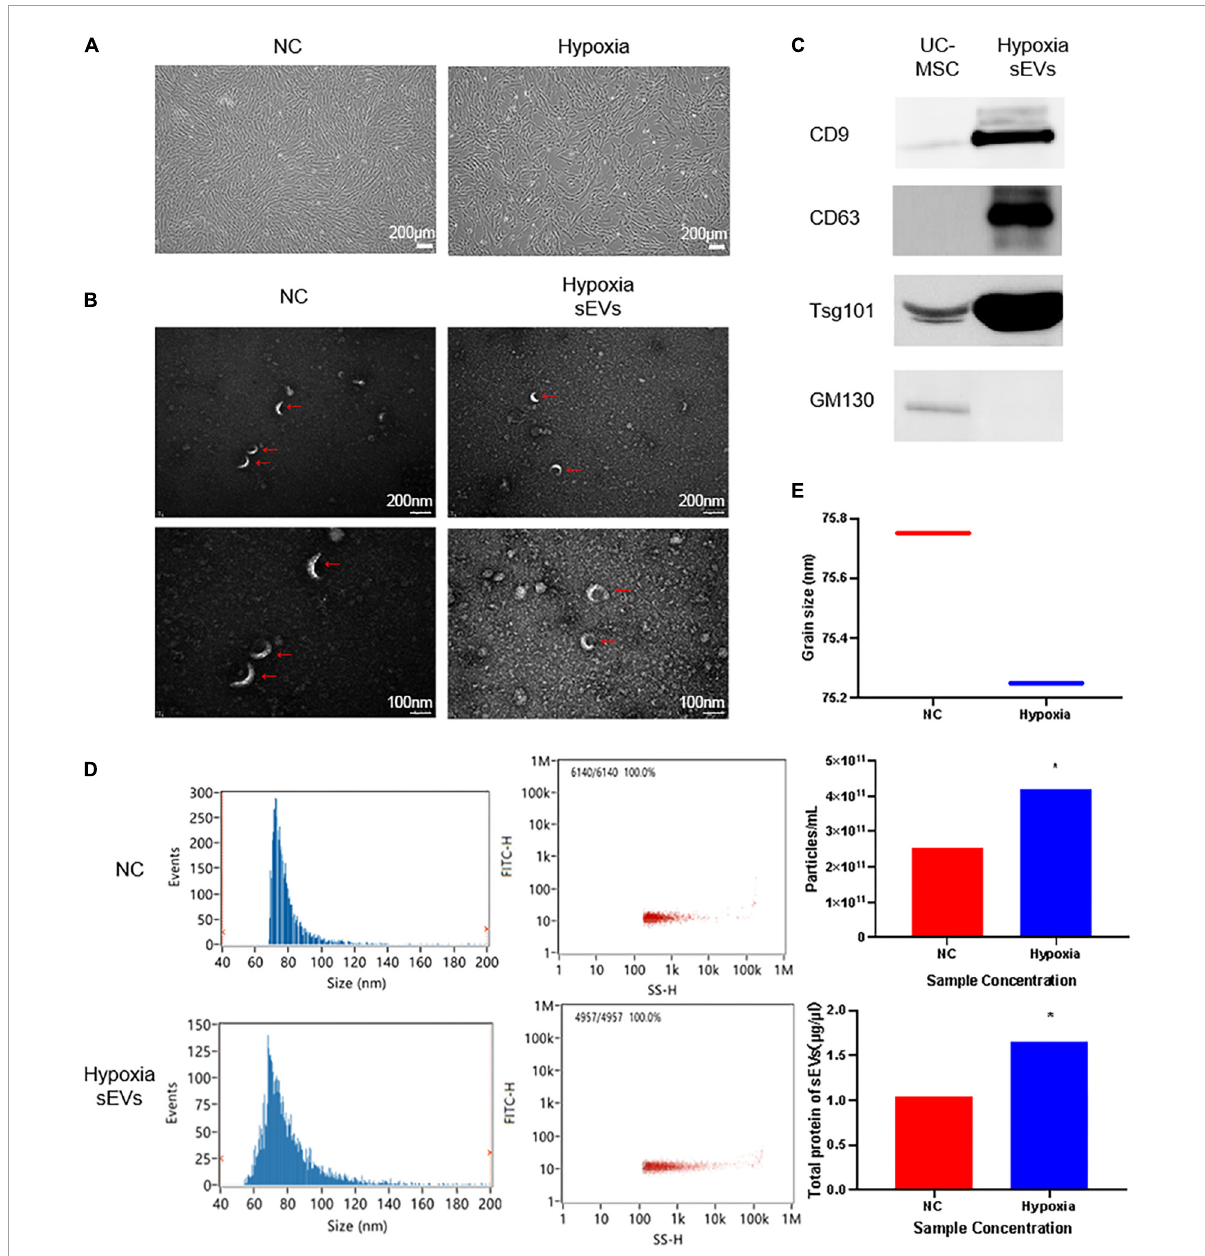
FIGURE1 Identification of UC-MSC-derived sEVs in hypoxic culture: (A) Cell culture: UC-MSCs under normoxic culture and hypoxic culture underwent microscopic examination to assess their morphology. UC-MSCs were seeded in T175 flasks at a density of 0.6 × 10 6 cells/cm 2 , cultured under different conditions for 72 h, and then observed under a microscope. The cell viability was greater than or equal to 98%, and the cell convergence rate was greater than 85%. (B) Transmission electron microscopy (TEM) of sEVs to assess morphology: upper, 20,000 × field of view; lower, 2 × zoomed image. (C) Determination of a characteristic antigen on sEVs: Intact UC-MSCs were used as a control, and the extracted hypoxic cultured UC-MSC-derived sEVs exhibited characteristic surface antigen expression. GM130 was used as a negative control marker. Statistical significance, p < 0.05. (D) Nano-FCM was used to determine the sEV particle distribution and scattered light parameters; the main peak distribution between 30 and 150 nm and median of 75 ± 0.25 conformed to the characteristic diameter distribution of sEVs.